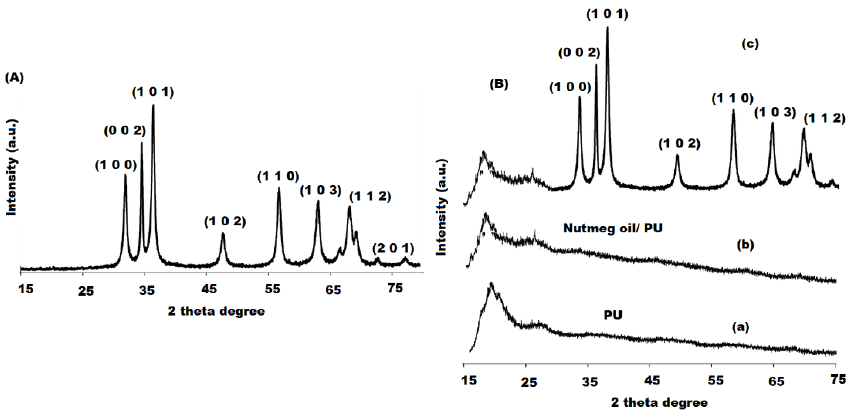
Figure 5. XRD spectrum of ( A ) ZnONPs and ( B ) plain PU ( a ), nutmeg oil ( b ) and bionanocomposite ( c ) in 20–80 wave number